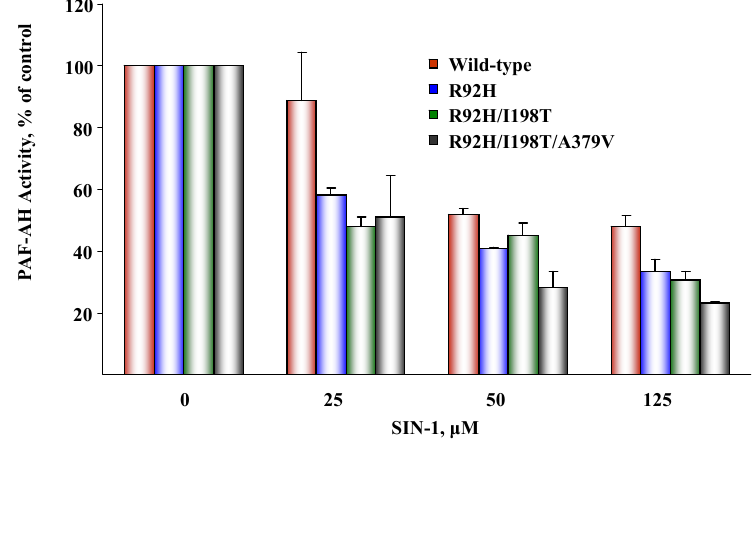
Figure 6. Susceptibility of PAF-AH variants to oxidative inactivation mediated by